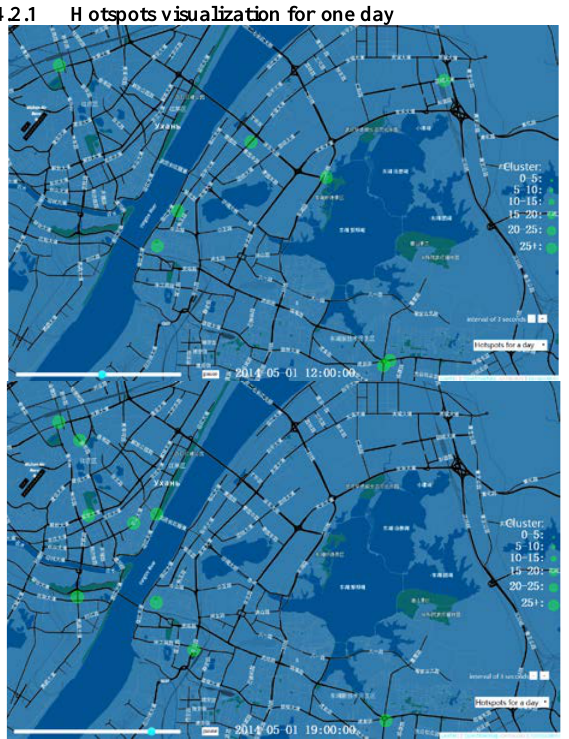
Figure 12. Hotspots for pickup sites at different time on May 1. Fig. 12 is the visualization of hotspots data at different time on May 1. Each circle on the map is a hotspot for pickup points, and its radius is determined by the number of pickup points that make up the hotspot. All the hotspots on the map are in the same colour, indicating that the hotspots are on the same day.